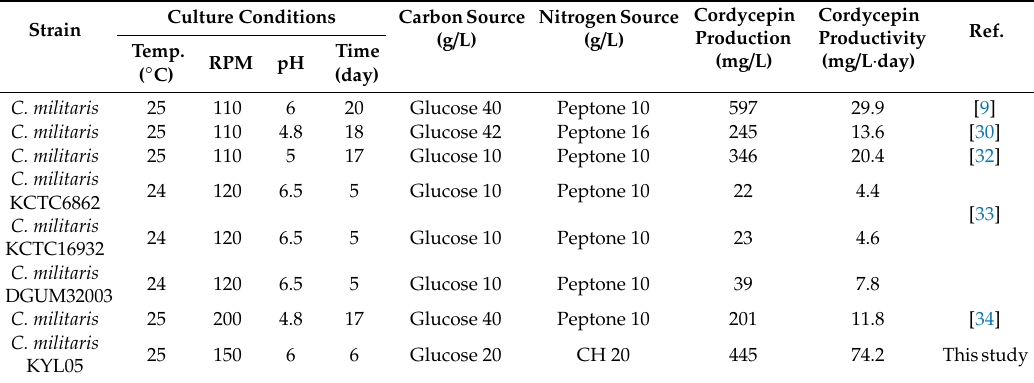
Table 1. Summary of culture conditions of C. militaris for cordycepin production. Culture Conditions CarbonSource Strain (g /